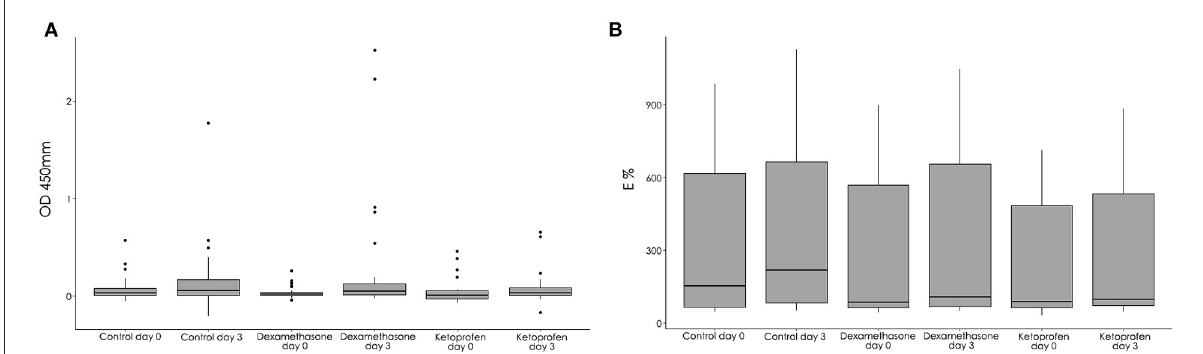
FIGURE4 Interferon-gamma release assay (IGRA) values expressed as optical density (OD) in the dexamethasone, ketoprofen and control groups at day 0 and day 3 (A) and P22 ELISA values expressed as ELISA percentage (E%) in the dexamethasone, ketoprofen and control groups at day 0 and day 3 (B)